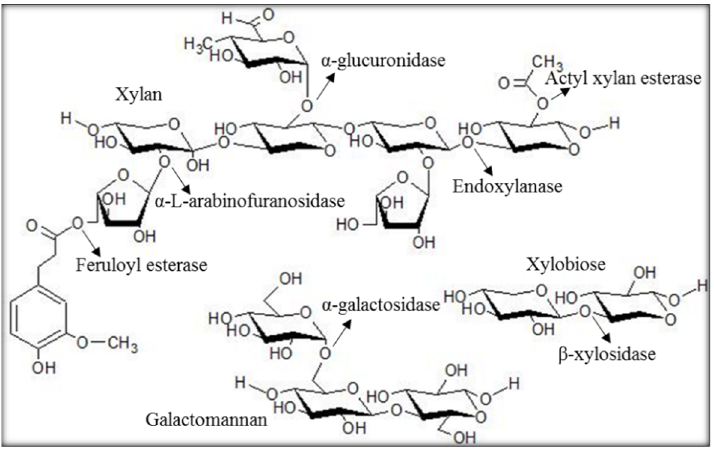
Figure 1. Hemicellulose subunits and breakdown . Structure of major xylan types and enzymes involved in subunit breakdown are identified with arrows indicating enzyme specificity.